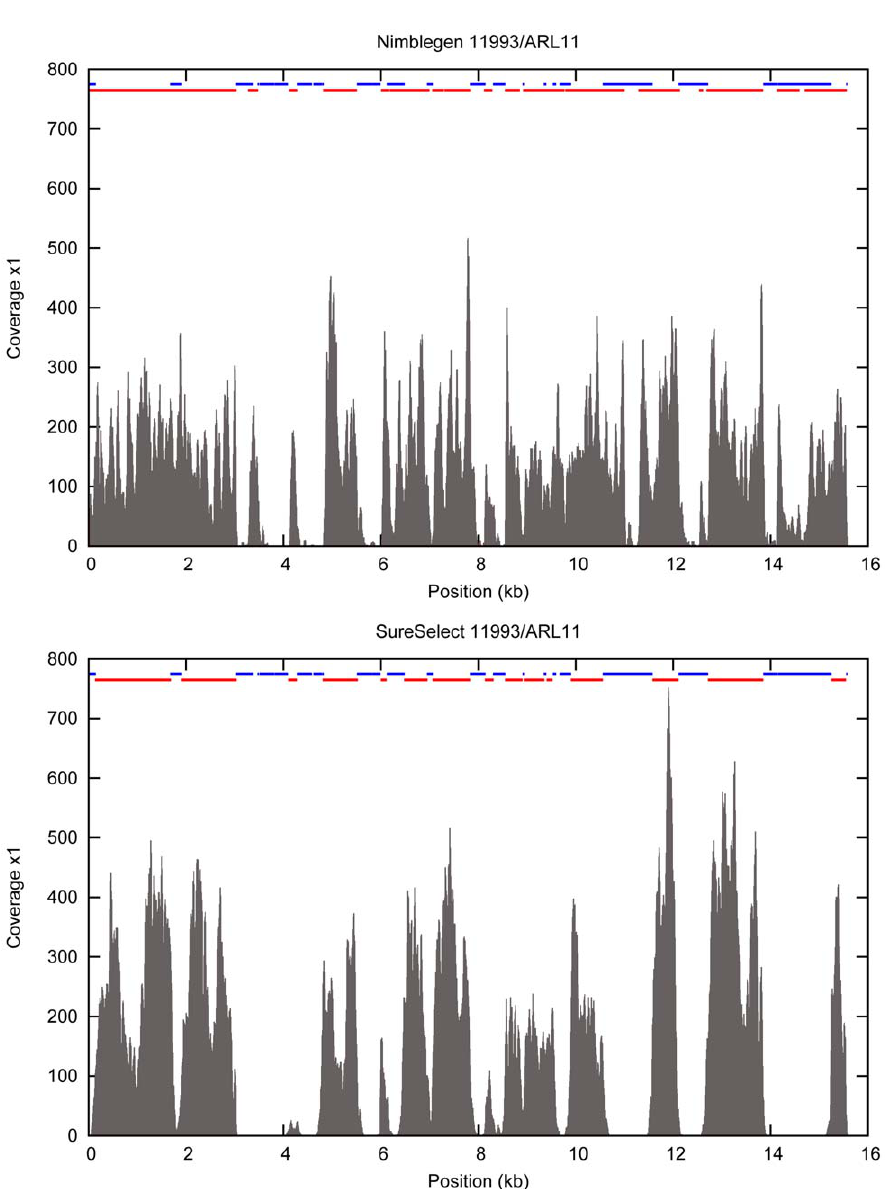
Figure 2. Coverage of a single gene. Per base coverage plotted along ARL11 in the sample NA11993 in sequencing libraries prepared with Nimblegen (top) and SureSelect (bottom) methods. The bars at the top of the graph mark the regions that are targeted by probes in each design (red) and the repeat elements as determined by RepeatMasker (blue).